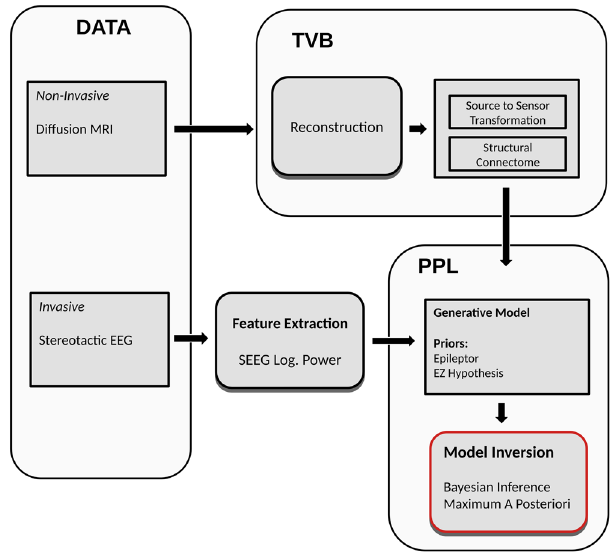
Fig. 1 End-to-end work fl ow for identifying spatio-temporal seizure propagation patterns in focal drug-resistant epilepsy patients. Diffusion MRI and SEEG data are collected for each patient. From this data, structural connectome and the transformation from source-to-sensor space is computed. SEEG recordings are preprocessed to extract data features such as log power over a sliding window, which could be modeled using 2D Epileptor. A generative model is de fi ned over the 2D Epileptor parameters and observed SEEG log power using a PPL called Stan. Model inversion is performed using maximum a posterior techniques to identify 2D Epileptor parameters that best explain the observations. PPL, probabilistic programming language; SEEG, stereotactic electroencephalography; TVB, The Virtual